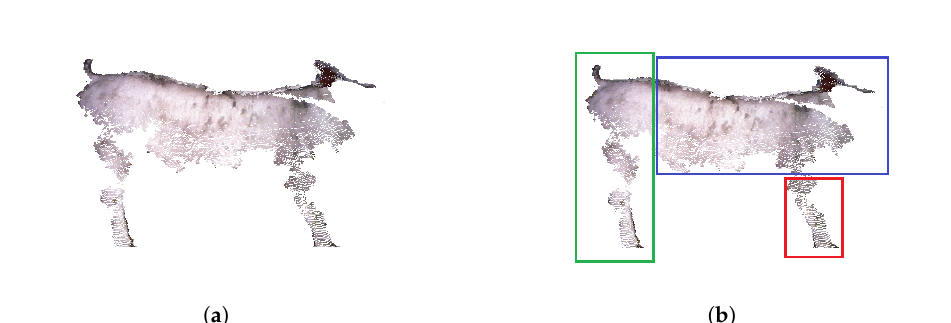
Figure 5. Virtual image ( a ) and labelled areas of three body parts ( b ). The areas of the body, foreleg, and hind leg are labelled in blue, red, and green,